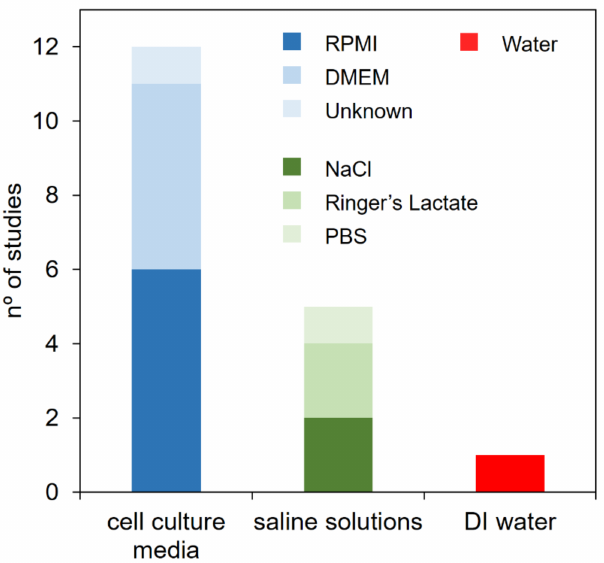
Figure 2. Three different kinds of liquids were used to generate PCL for in vivo